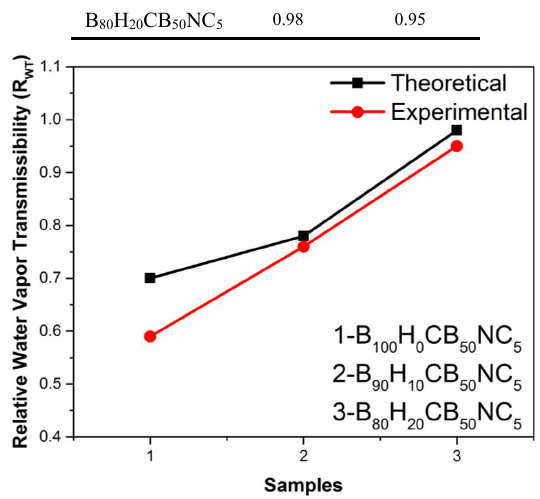
Figure 5: Comparison of theoretical relative water vapor transmissibility against the